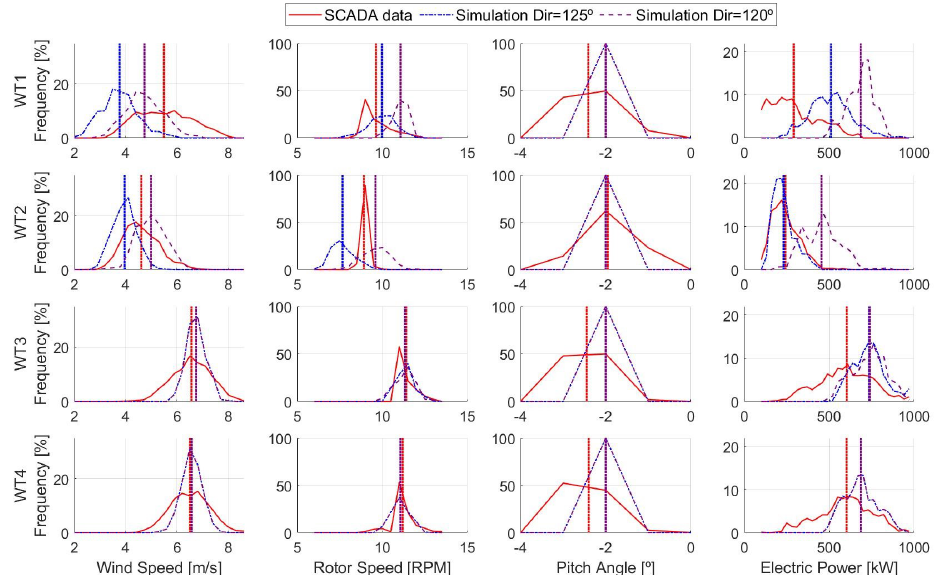
Figure 8. Histograms of wind speed (m/s), rotor angular speed (RPM), pitch angle ( ◦ ), and electric power (kW) from the SCADA data and simulation of wind turbines WT1, WT2, WT3, and WT4. Inflow condition of the simulation: Wind direction 120 ◦ and 125 ◦ (wake interaction) and wind speed below rated. Vertical dashed lines represent the mean value of each